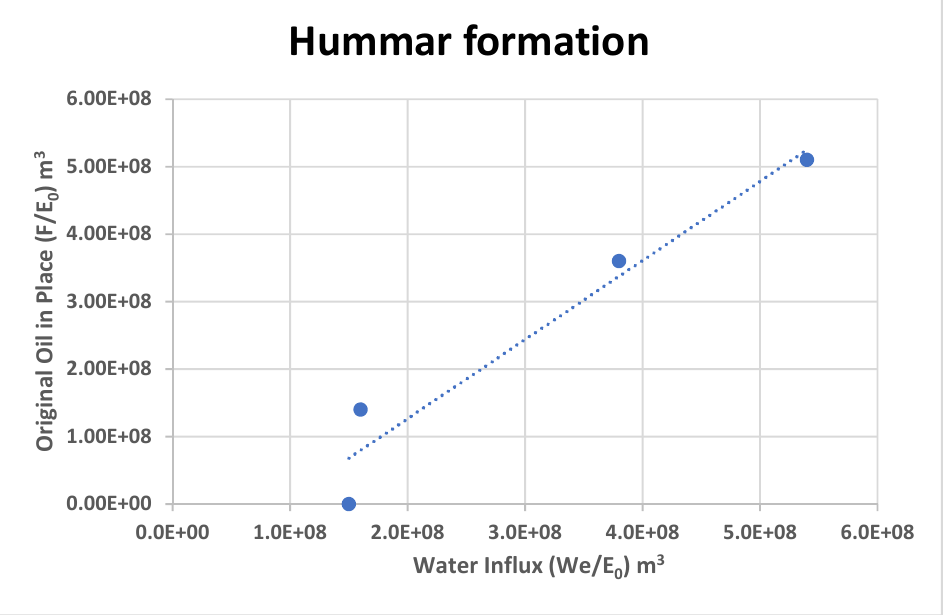
Figure 4. Reserve estimation from water influx calculations for the Hummar formation.